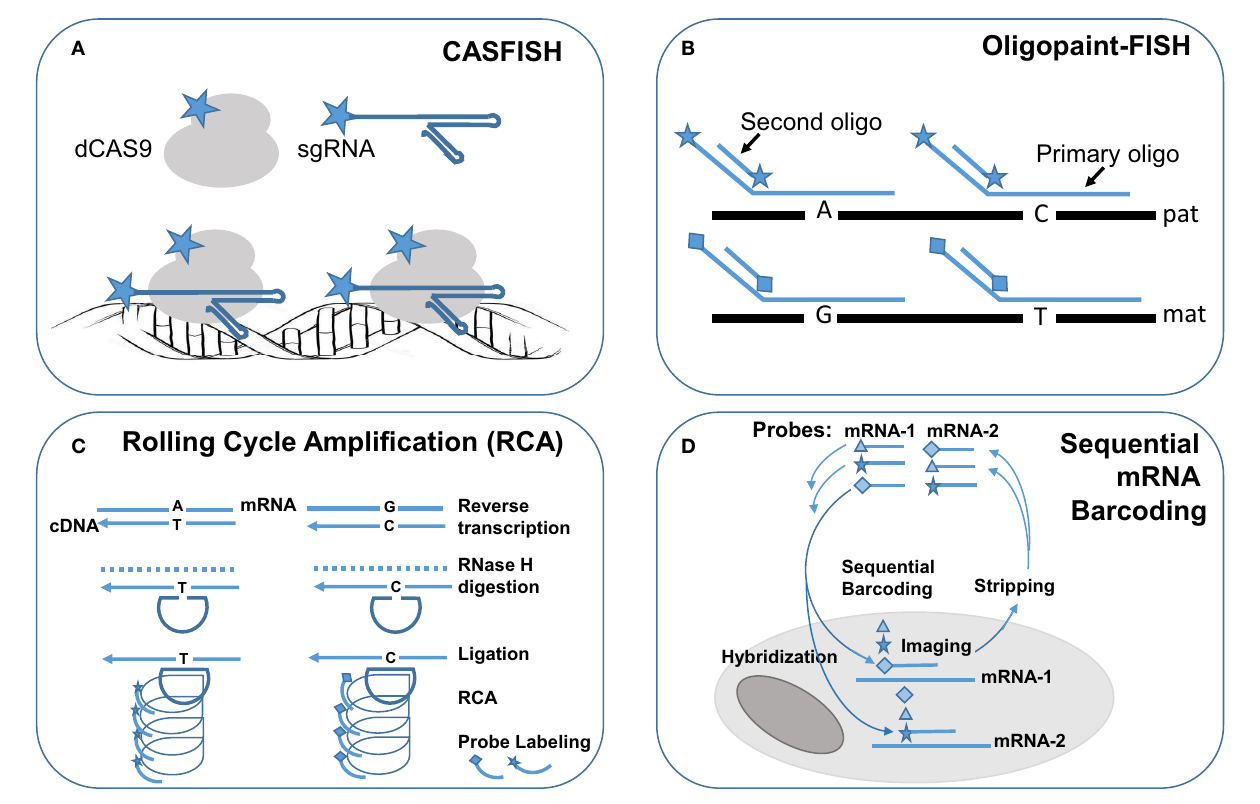
FIGURE 2 | Single molecule FISH techniques for research application in single cells. Schematic drawings of single molecule FISH methods: (A) Cas-9 mediated FISH (CASFISH) using fluorophore-coupled sgRNAs and dCAS9. (B) Oligopaint-FISH using fluorophore-coupled primary oligonucleotides for targeted SNP loci and fluorophore-coupled second oligonucleotide to enhance labeling efficiency shows differential labeling of paternal (pat) and maternal (mat) chromosomes. (C) single molecule RNA FISH by rolling cycling amplification (RCA) using padlock probes targeting to reverse transcripted cDNA with different alleles followed by ligation, cycling amplification and specific fluorophore-couple probe hybridization and visualization. (D) Sequential barcoding of multiplex different mRNAs by repeat rounds of hybridization, imaging, and stripping. Star, diamond, and triangle are symbols for different fluorophores.